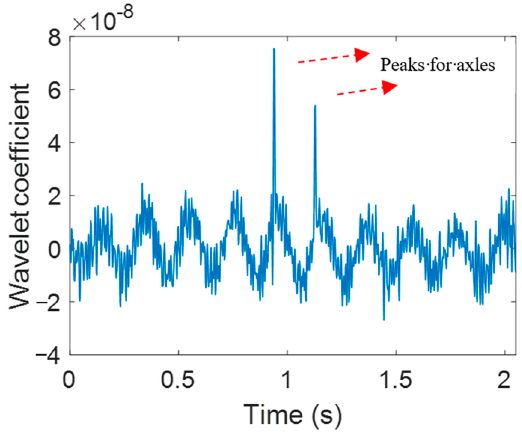
Figure 5. Wavelet coefficient at scale 5.